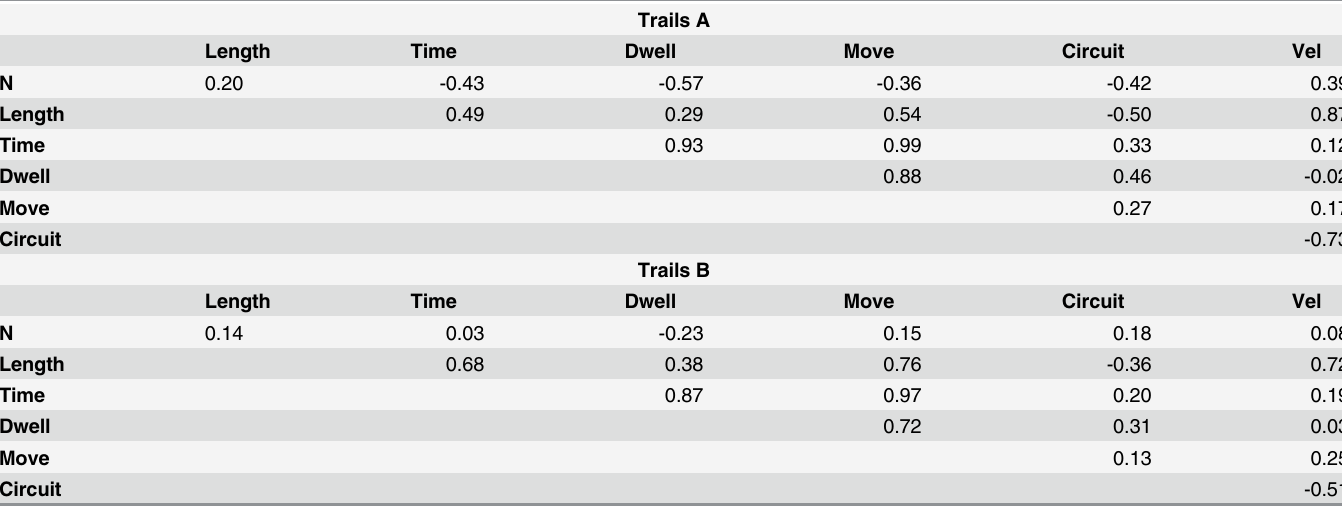
Circuit -0.51 N = circle number. Dwell = dwell-time. Move = move-time. Circuit = circuitousness. Vel = velocity. Given the sample size (N = 24), correlations with |r| > 0.41 are statistically signi fi cant at the p < 0.05 level (uncorrected for multiple comparisons). Data from Experiment 1.